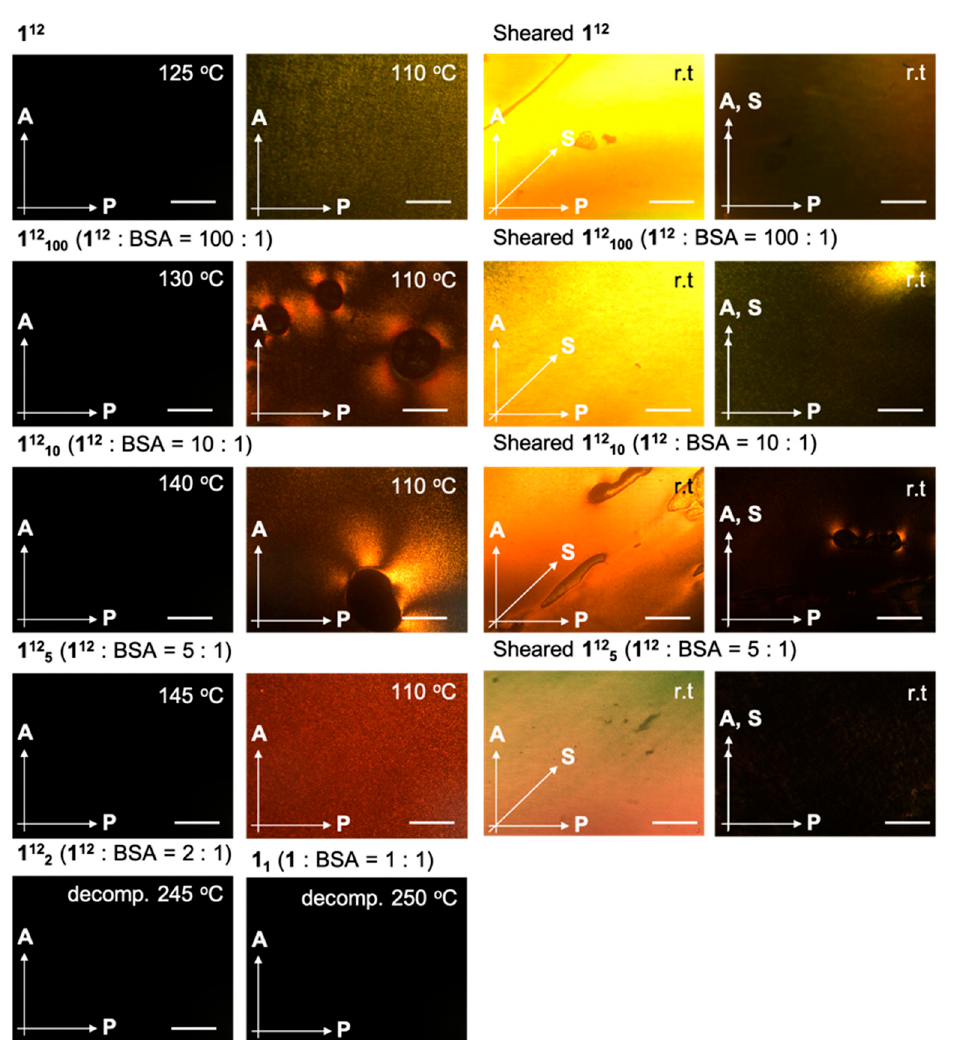
Figure3. Polarizedopticalmicroscopic(POM)observations 1 andcomplexesof 1 withbenzenesulphonic Figure 3. Polarized optical microscopic (POM) observations 1 and complexes of 1 with acid (BSA) for 1 12 100 , 1 12 10 , 1 12 5 , 1 12 2 , and 1 12 1 . All scale bars indicate 100 µ m. A, P, and S indicate benzenesulphonic acid (BSA) for 1 12100 , 1 1210 , 1 125 , 1 122 , and 1 121 . All scale bars indicate 100 μ m. A, P, and analyzer, polarizer, and sheared direction, respectively. 1 12 100 , 1 12 10 , 1 12 5 , 1 12 2 , and 1 12 1 indicate 1 : S indicate analyzer, polarizer, and sheared direction, respectively. 1 12100 , 1 1210 , 1 125 , 1 122 , and 1 121 indicate BSA = 100:1, 10:1, 5:1, 2:1, and 1:1 (in molar), 1 : BSA = 100:1, 10:1, 5:1, 2:1, and 1:1 (in molar), respectively.